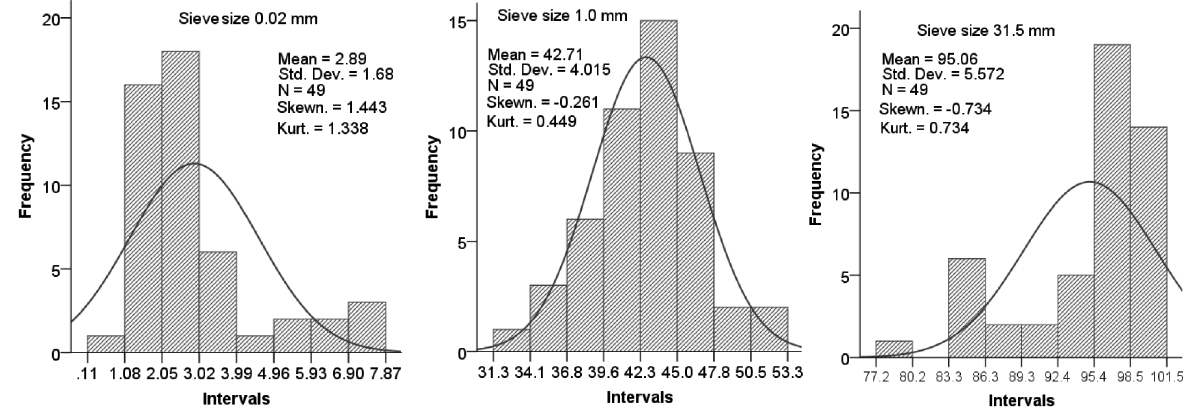
Fig. 6. Histograms of the ASB mixture percent passing, theoretical curves of normal distribution and statistical